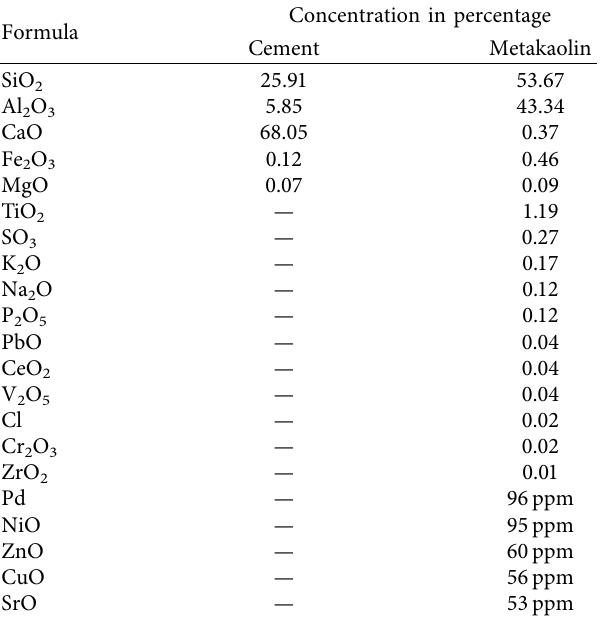
Table 1: Chemical composition of cementitious materials used.